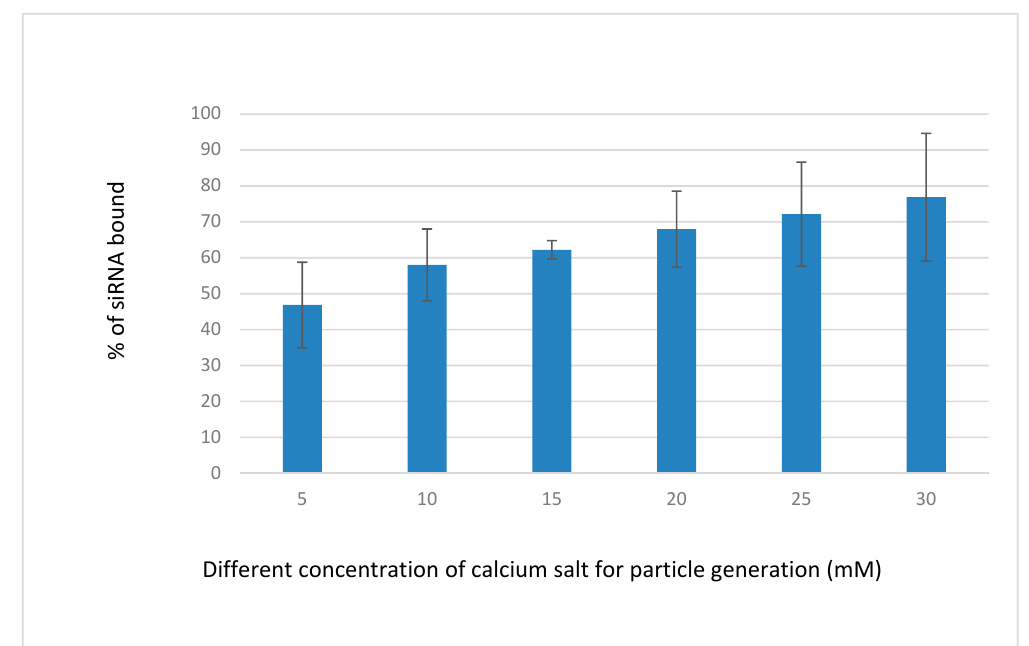
Figure 5. Binding efficiency of fluorescence-labeled siRNA-CAs complex developed by mixing 5–30 mM of exogenous CaCl 2 (1–6 μ L from 1 M stock), followed by incubation of the mixture for 30 min at 37 °C, as described in detail in Section 2.3. The concentration of the allstars negative siRNA (AF 488) (QIAGEN) (fluorescence siRNA) was 10 nM.